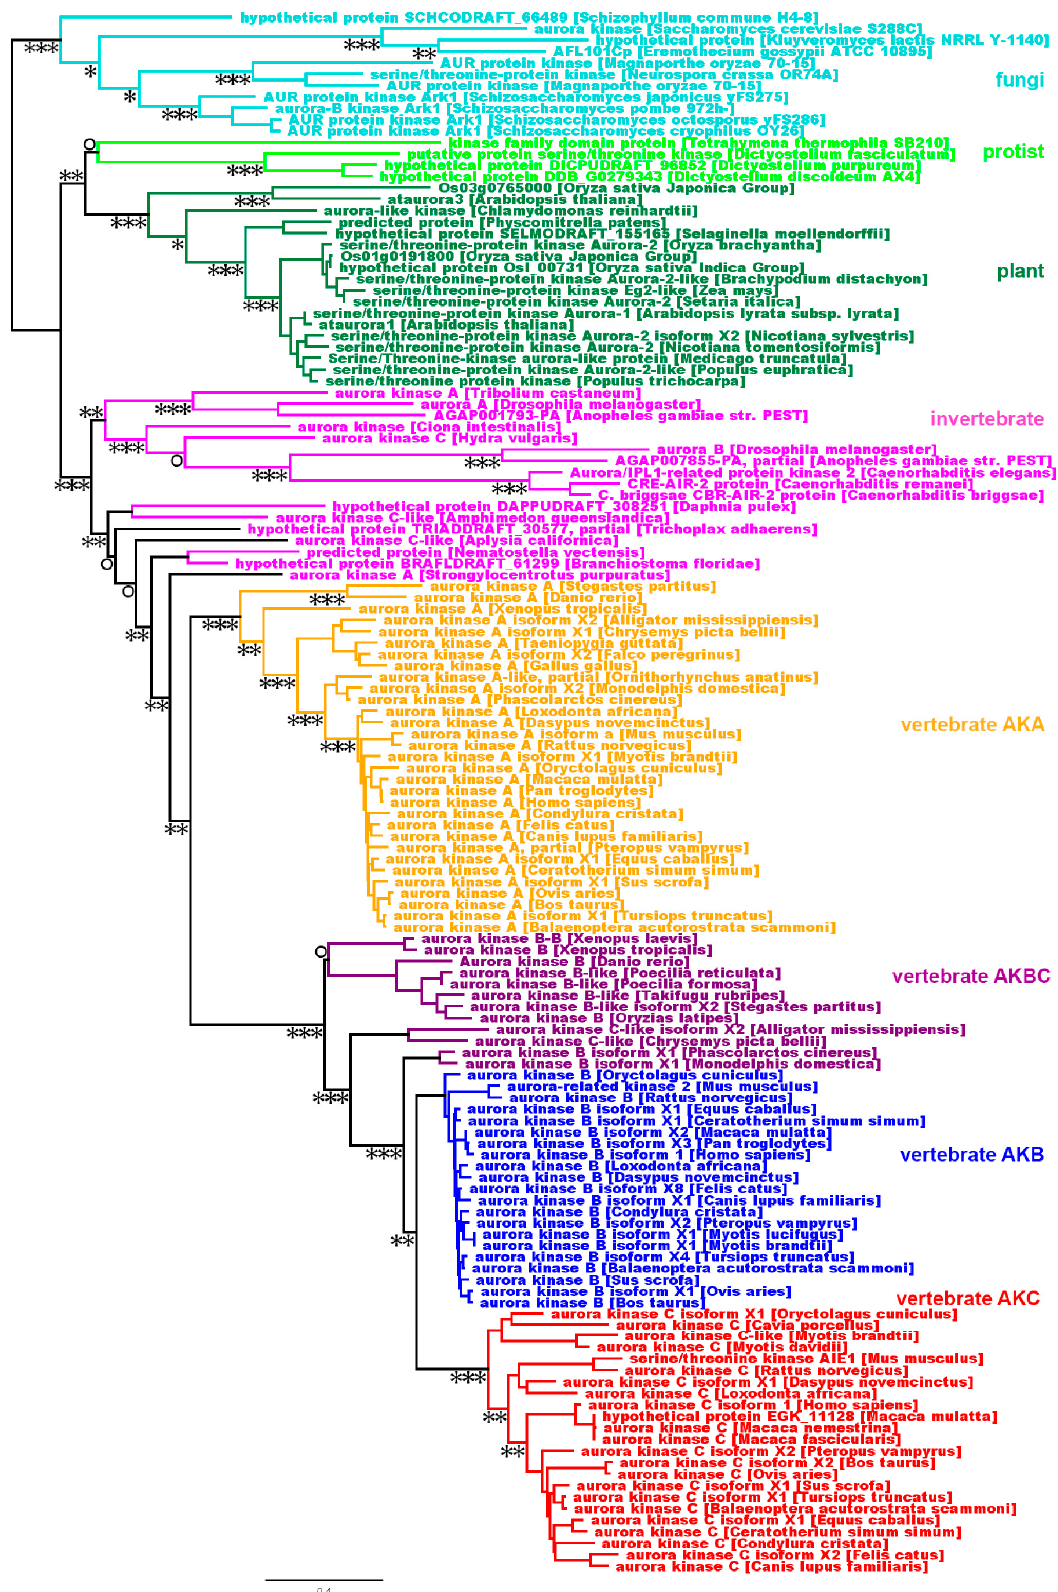
Figure 2. The evolution of the AK gene family. An AK phylogenetic tree was built using FatTree 2. Horizontal lines are proportional to the substitution rate. The bar represents 0.3 changes per amino acid. Local support values are marked with ***, **, * and ○ for 0.9–1.0, 0.7–0.89, 0.5–0.69 and <0.5, respectively.